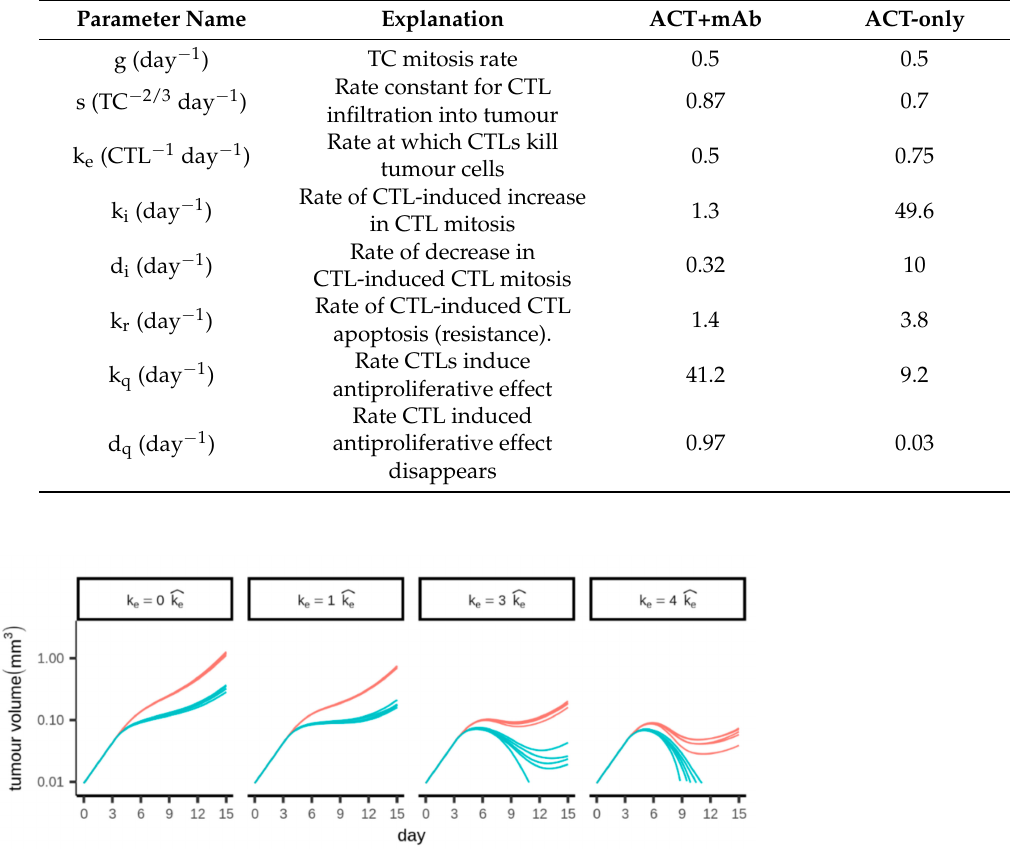
Table 2. Best fitting model parameter values and their explanations.